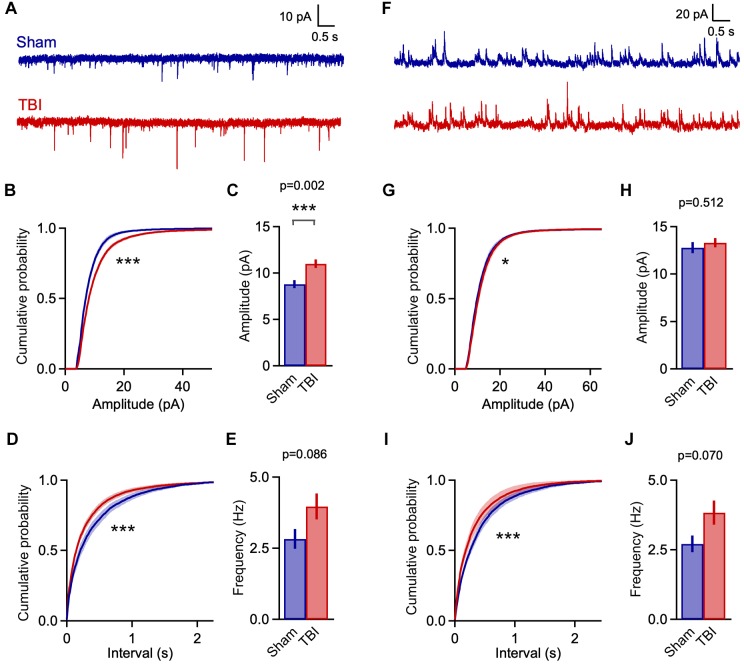
Rapid increases in excitatory input 1 h after mild TBI. (A) Example traces showing spontaneous EPSCs at 1 h after a single injury. (B,C) Cumulative histograms and mean values for sEPSC amplitudes. Excitatory events were significantly larger in the TBI group [p = 1e-08, k = 0.122; K–S test; n = 2016 sham, 4050 TBI events; 8.8 ± 0.4 vs. 11.0 ± 0.5 pA for sham and TBI; p = 0.0025; t(46) = 3.201; 2 sample t-test; n = 8 mice, 18 cells for sham; 12 mice, 30 cells for TBI]. (D,E) Cumulative histograms for sEPSC interval and bar plot of mean frequency. TBI also decreased the interval between excitatory inputs (p = 1e-08, k = 0.101; K–S test; n = 2016 sham, 4050 TBI events), although mean frequency showed only a trend toward increase [2.8 ± 0.4 vs. 4.0 ± 0.4 Hz for sham and TBI; p = 0.086; t(46) = 1.755; 2 sample t-test; n = 8 mice, 18 cells for sham; 12 mice, 30 cells for TBI]. (F) Example traces showing spontaneous inhibitory inputs. (G,H) TBI caused a slight shift toward larger amplitudes (p = 0.0002, k = 0.049; K–S test; n = 2664 sham, 6810 TBI events), although mean sIPSC size was unaffected [12.8 ± 0.6 vs. 13.3 ± 0.5 pA for sham and TBI; p = 0.512; t(46) = 0.661; 2 sample t-test; n = 8 mice, 18 cells for sham; 12 mice, 30 cells for TBI]. (I,J) TBI altered the distribution toward more frequent inhibitory inputs (p = 1e-08; k = 0.102; K–S test; n = 2664 sham, 6810 TBI events), although mean frequency showed only a trend [2.7 ± 0.3 vs. 3.8 ± 0.4 Hz for sham and TBI; p = 0.070; t(46) = 1.860; 2 sample t-test; n = 8 mice, 18 cells for sham; 12 mice, 30 cells for TBI]. ∗ and ∗∗∗ indicate p < 0.05 and p < 0.01 for t-tests, and p < 0.01 and p < 0.0001 for K–S tests.